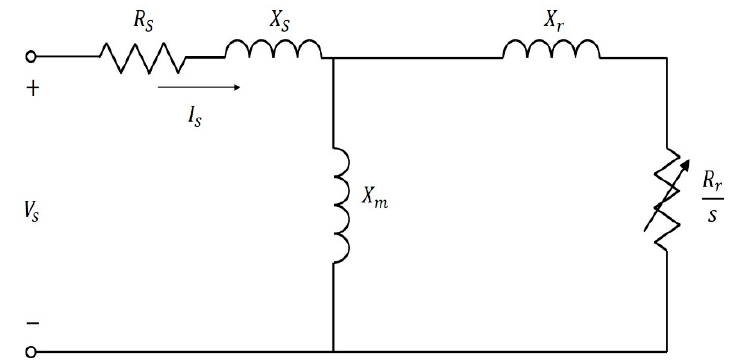
Figure 2. Induction motor equivalent circuit.